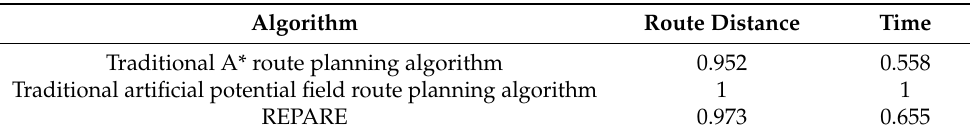
Table 2. Comparison of the three algorithms’ average time and distance.